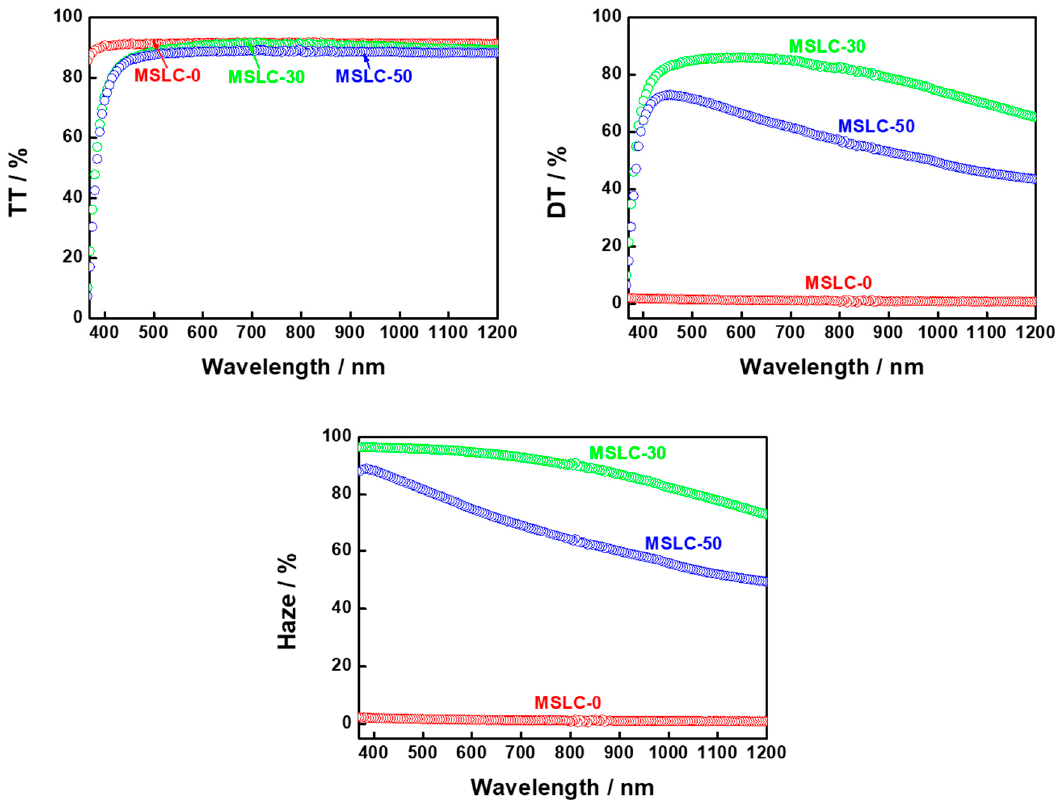
Figure 4. TT, diffusely transmitted (DT) and the optical haze spectra of three MSLC films using different LC mixing ratios at room temperature (RT).